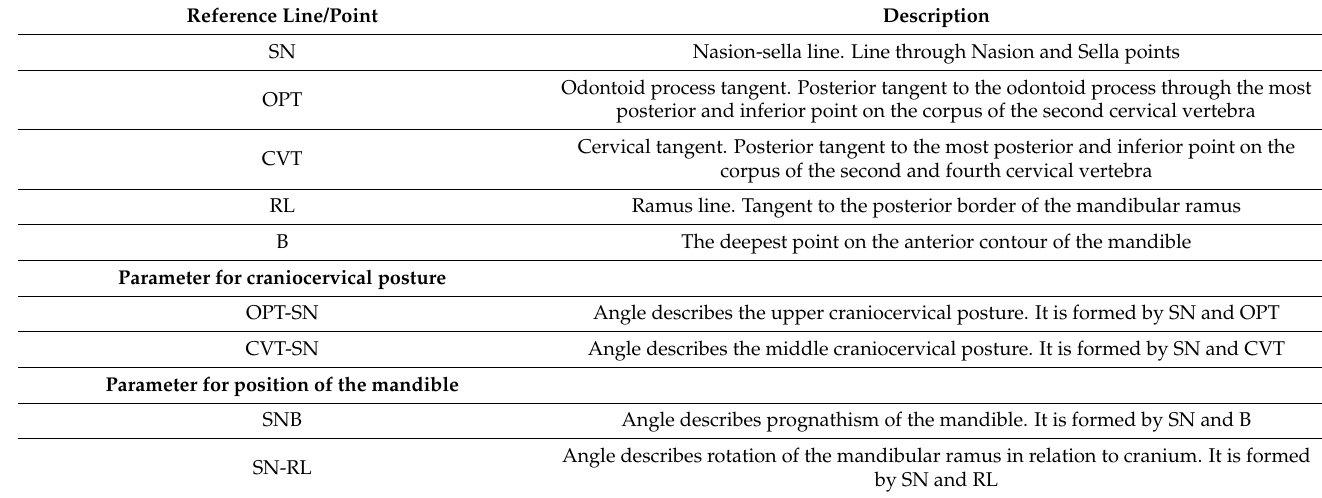
Table 3. Parameters used to assess craniocervical posture and mandible